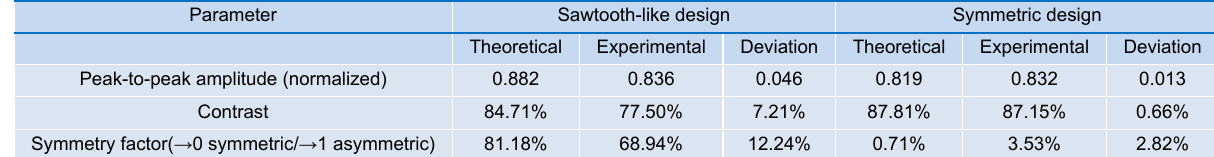
Table 2 | Parametric evaluations of the designed and desired